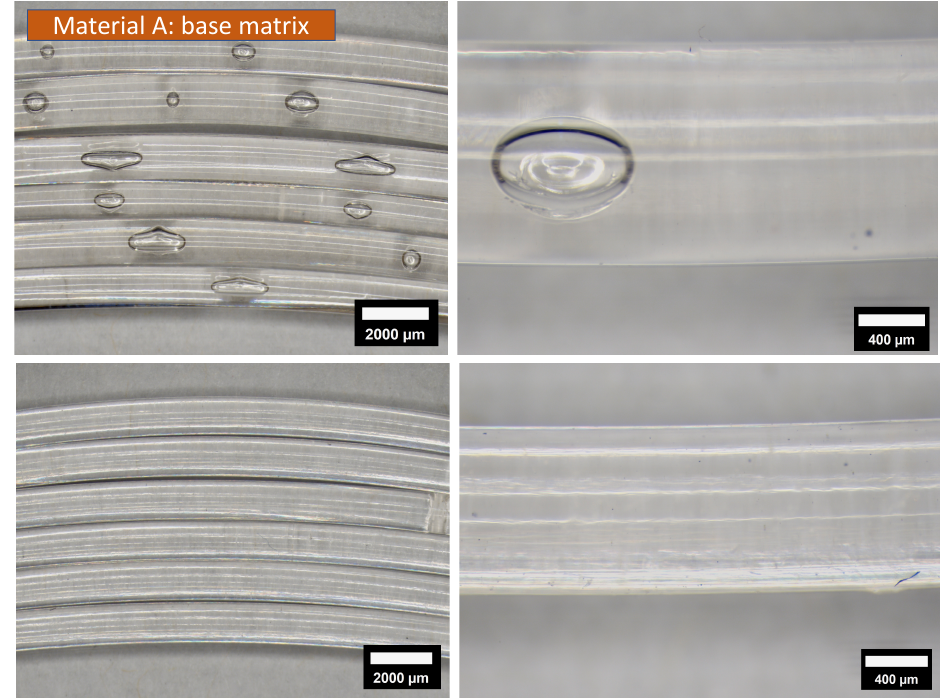
Figure 8. Microscopic images of base-matrix material A filament, PLA L130. Top: challenge such as voids and unmelted polymer during filament production. Bottom: good quality filament.